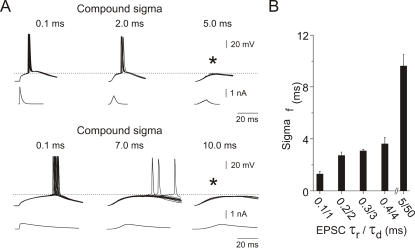
Reliability of spike generation as a function of input synchronization and EPSC shape. A, Spike responses to somatic injections of normalized compound EPSCs (τrise/τdecay 0.3/3 ms, top traces; τrise/τdecay 5/50 ms, bottom traces) with different levels of compound sigma. Compound sigma values for which spike responses failed to occur in 90% or more of the cases were termed “sigmaf” (marked by the asterisks in A). B, Compounds with fast EPSC kinetics failed to elicit spikes when the temporal jitter in the compound exceeded a few milliseconds (sigmaf≤4 ms, n = 4 cells). Spike responses to a compound EPSC with slow kinetics, on the other hand, were less sensitive to temporal jitter in the compound (sigmaf = 10±0.82 ms) (mean±s.e.m.).